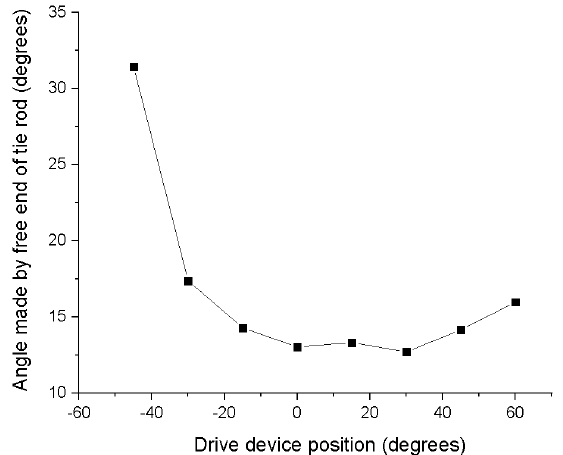
Figure 9. Variation of the angle ψ for different values of the angle β .